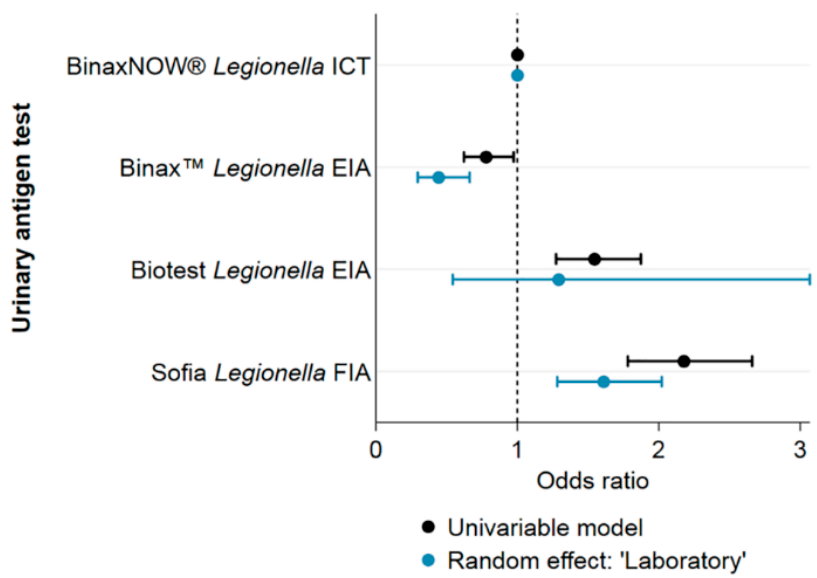
Figure 4. Differences in positivity across UAT test kits. Univariable regression results with and without random effect on “laboratory” for the outcome of having a positive test result for Legionella spp. in Switzerland, 2007–2016.